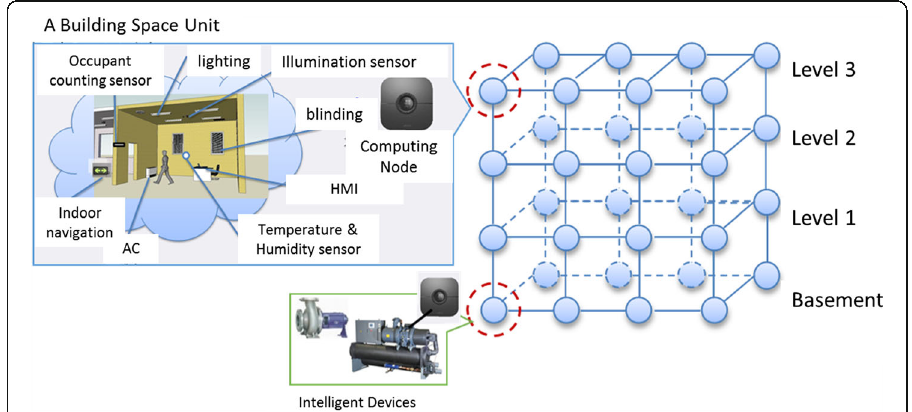
Fig. 2 An illustration of the decentralized control system in